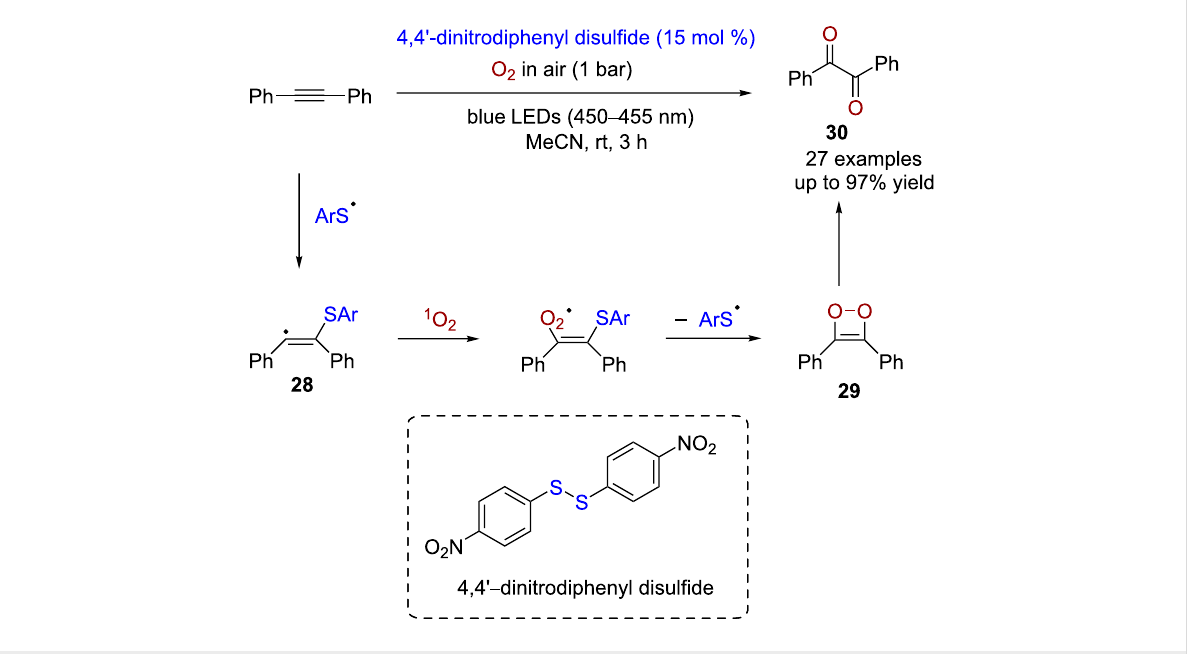
Scheme 8: Disulfide-catalyzed aerobic oxidation of diarylacetylene.